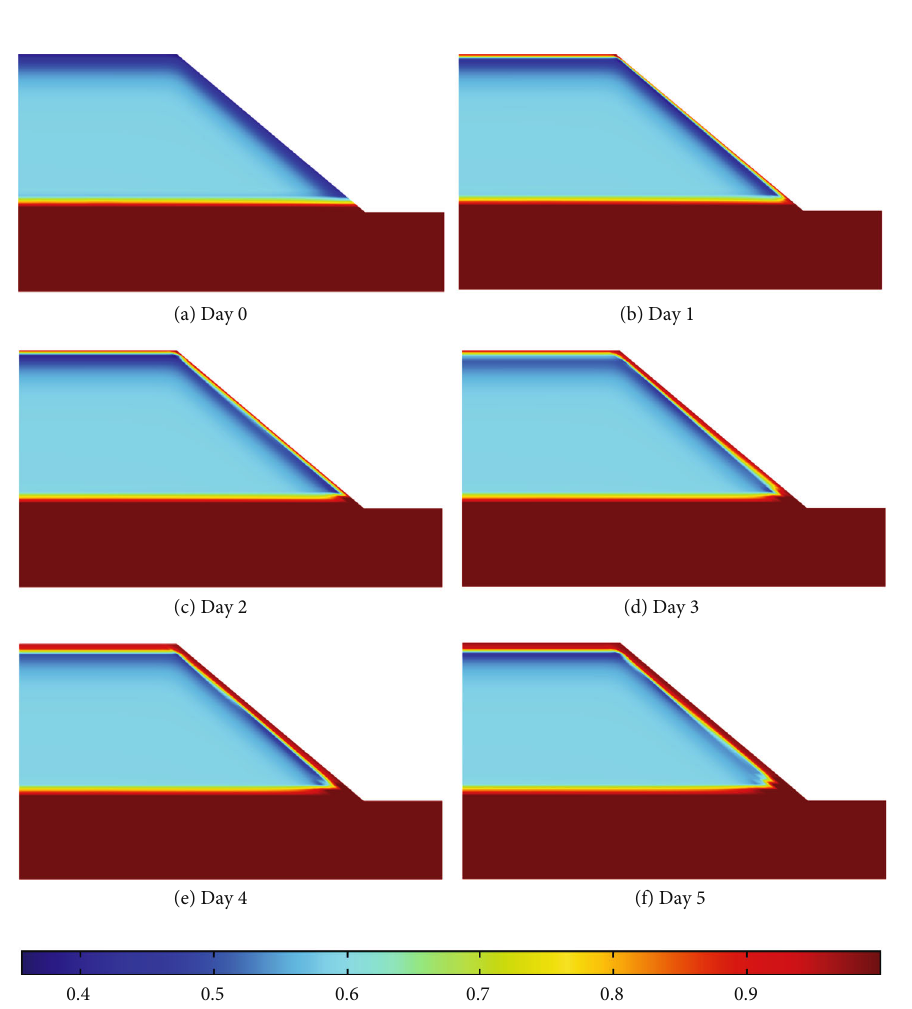
Figure 5: E ff ective saturation varies with rainfall time (coupling